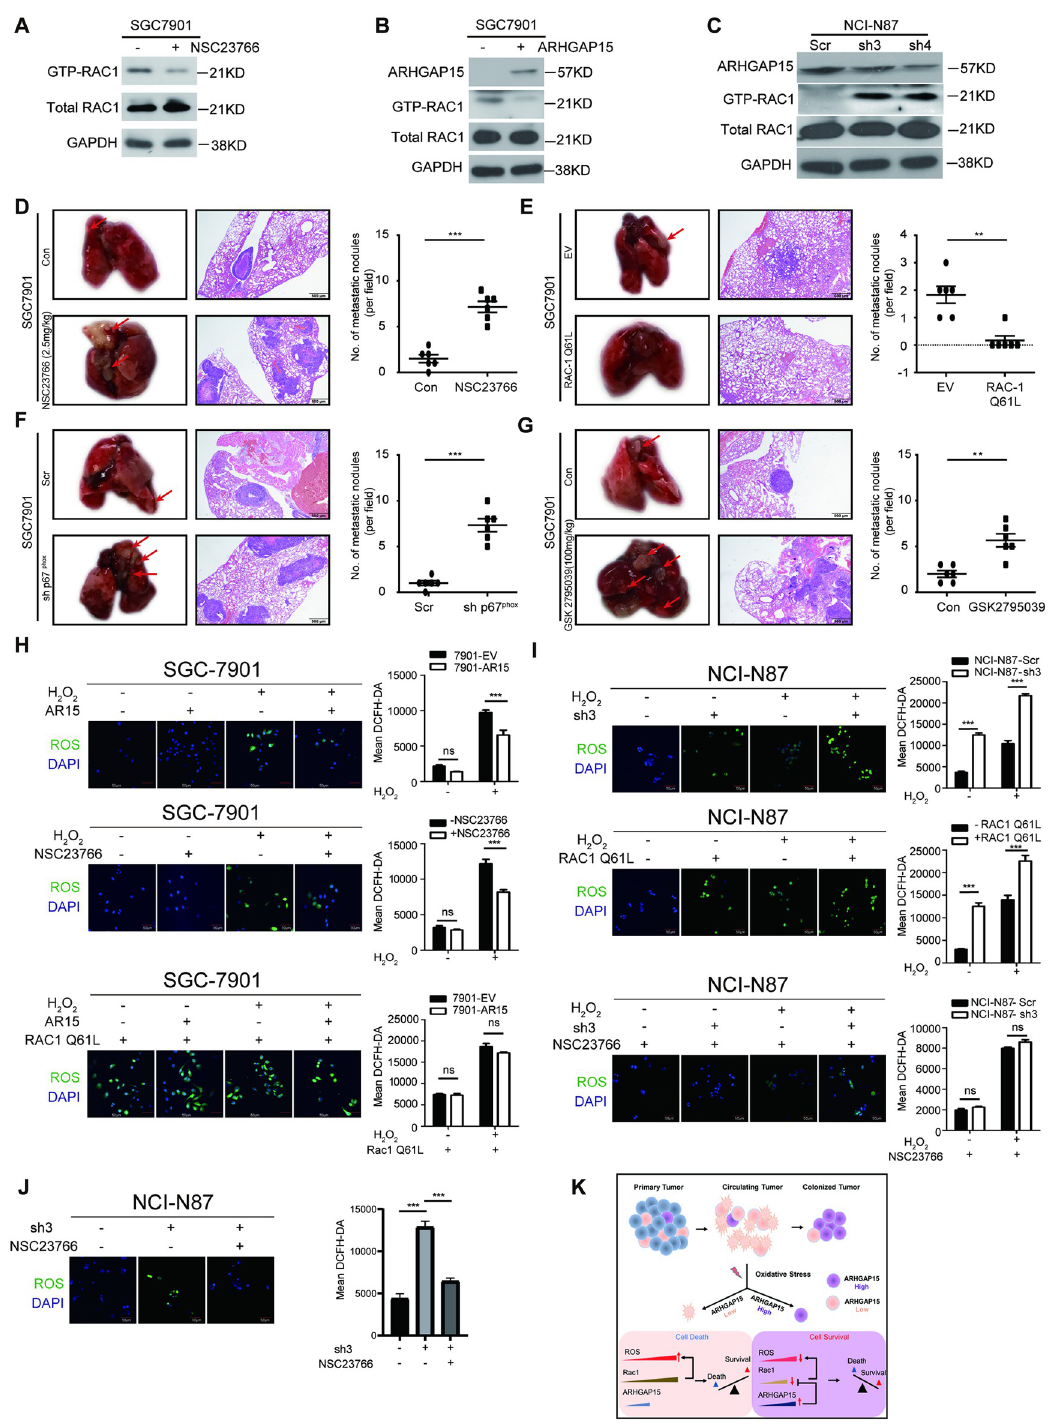
Fig 5. ARHGAP15 decreases intracellular ROS through inhibiting RAC1. (A) : Representative western blot images showed the activity of RAC1 was inhibited by NSC23766. GTP-RAC1 was the active form. (B) : RAC1 activity was suppressed by ARHGAP15 overexpression. (C) : ARHGAP15 knockdown enhanced RAC1 activity in NCI-N87 cell. (D-G) : In vivo metastatic assay based on SGC-7901 cells (n = 6 for each group). Metastatic lesions were shown by gross photos (Left) or H&E slides (Middle). The number of metastatic nodules per field under microscope were counted for comparison (Right). (D): Mice injected with tumor cells through the tail vein were subsequently intraperitoneally injected with corn coil or indicated dosage of NSC23766 every day. (E):